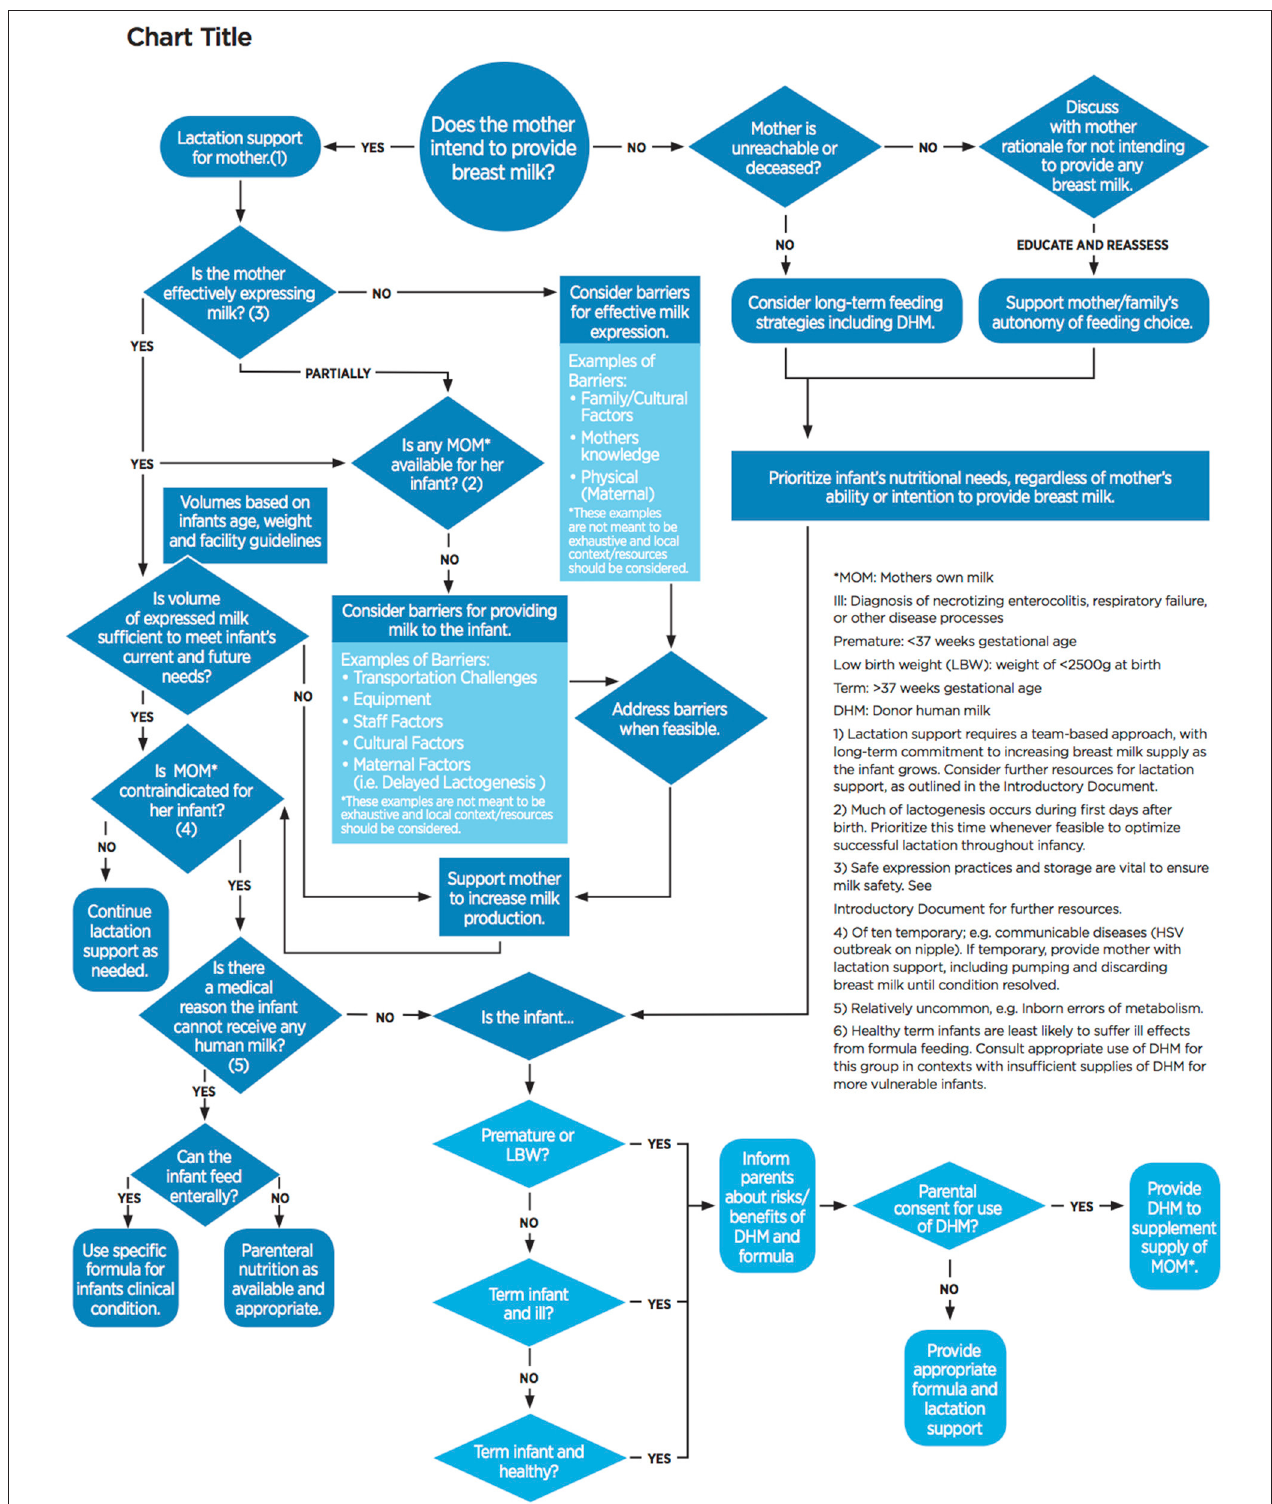
FIGURE 1 | Decision